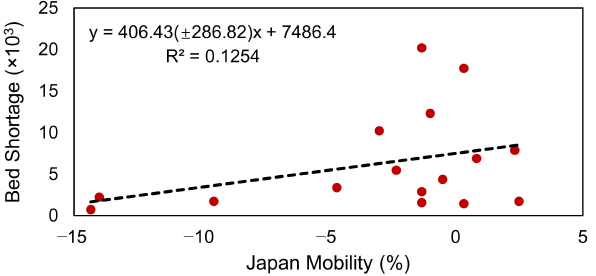
Figure A2. Intra-country mobility and hospital bed shortages in Japan since March 8 (the day with the lowest available data of intra-country